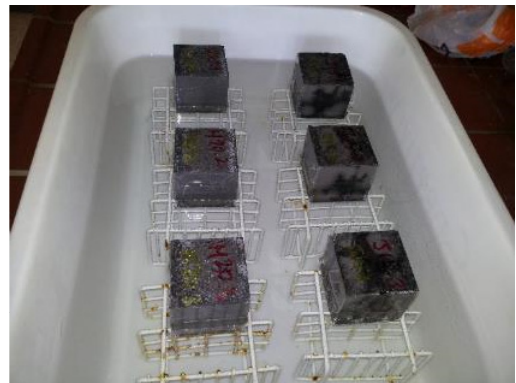
Figure 11. Photo of the tested specimens.